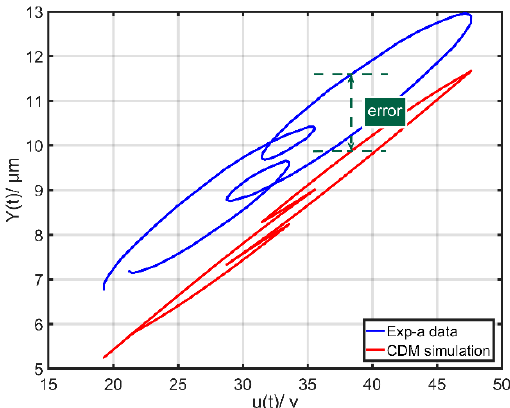
Figure 1. Comparison of the output displacements between experimental data (Exp-a) and simulation of the classical Duhem model (CDM).